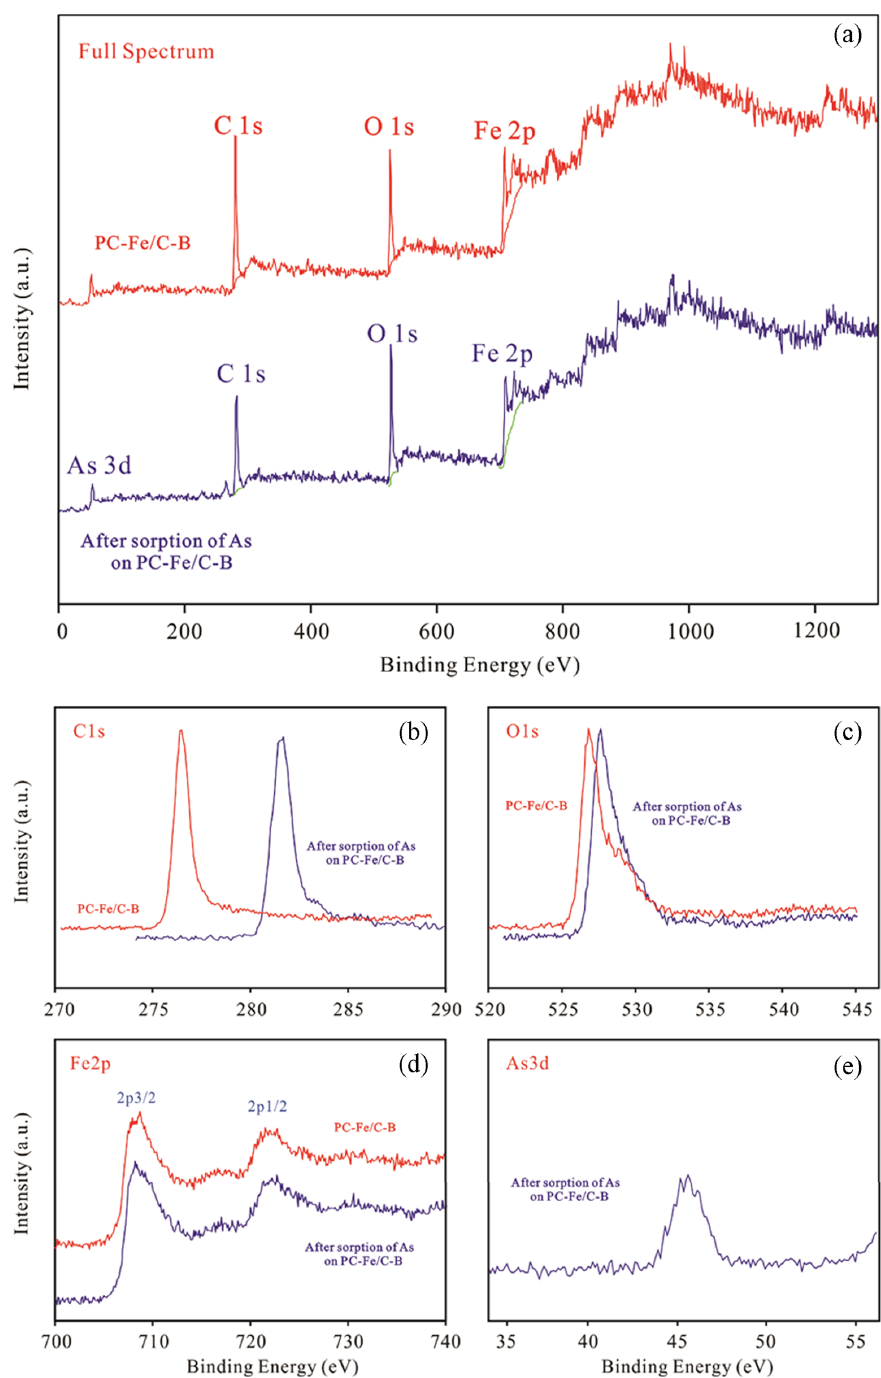
Figure 4. ( a ) XPS survey spectra and high ‐ resolution. ( b ) C 1s. ( c ) O 1s. ( d ) Fe 2p and ( e ) As 3d spectra of PC ‐ Fe/C ‐ B, before and after As(V) adsorption.